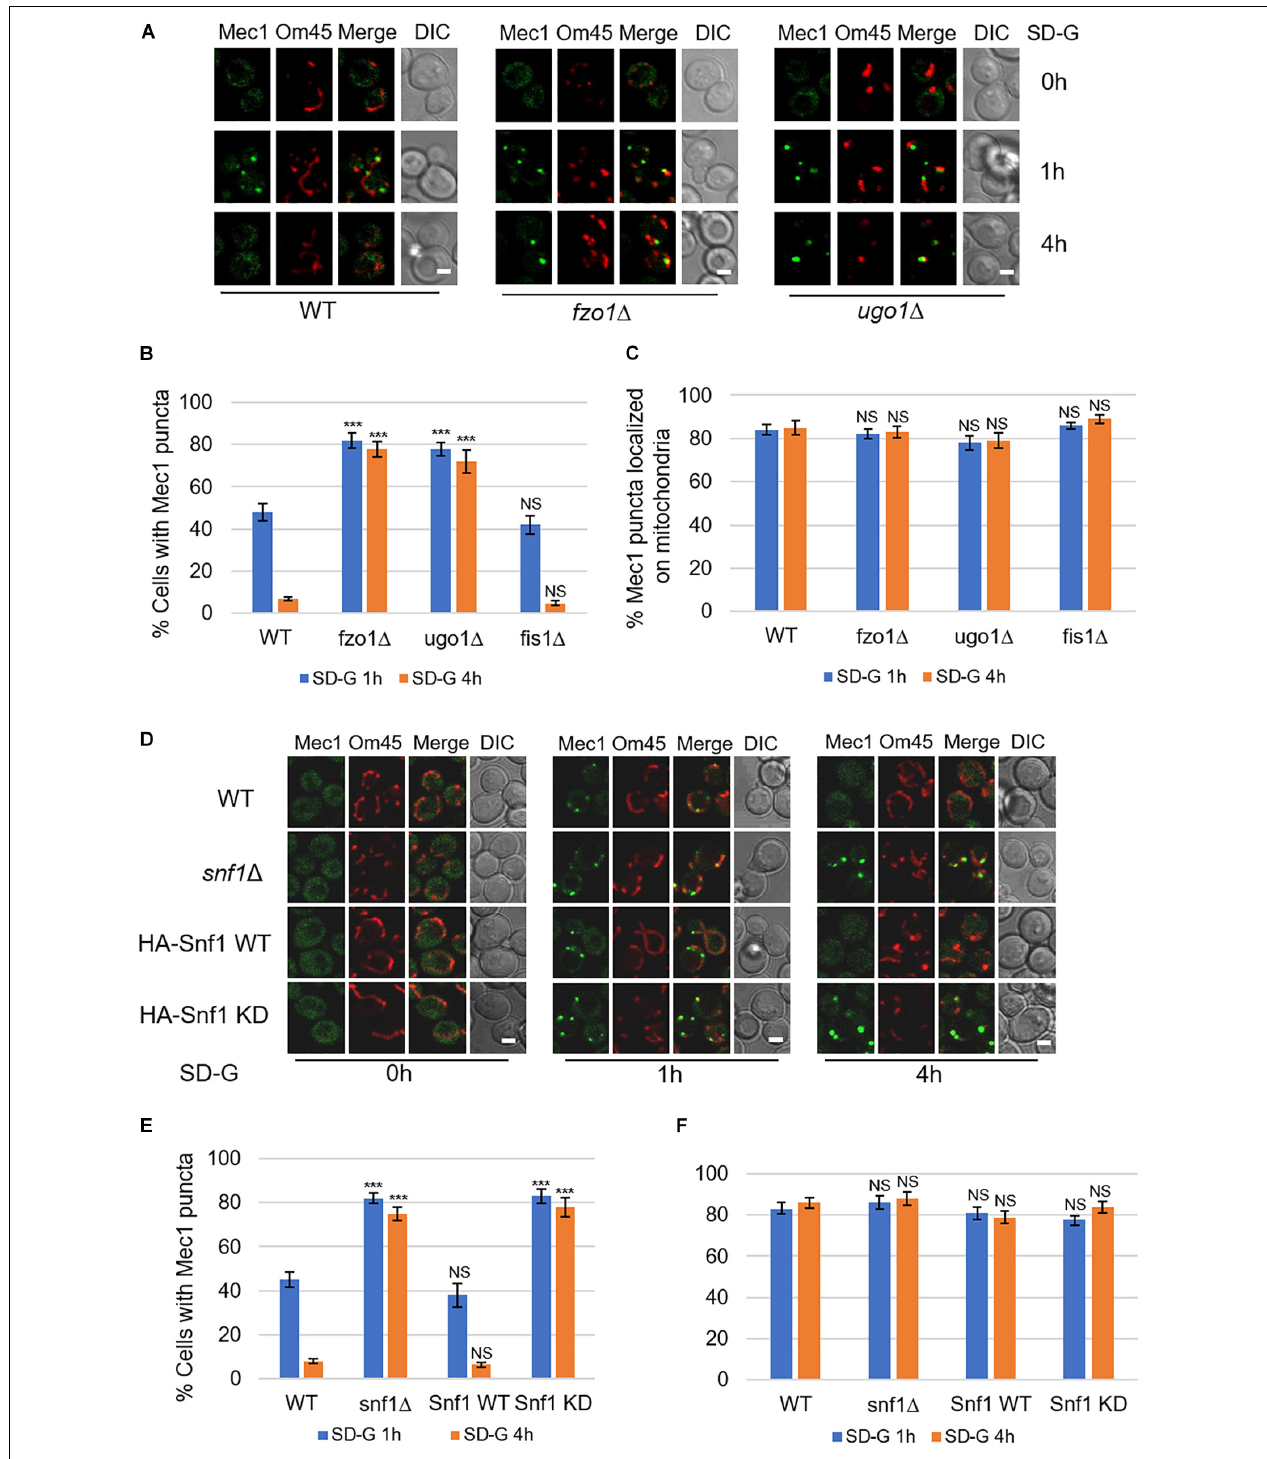
FIGURE 4 | Mitochondrial fusion machinery is required for the dissociation of Mec1 from mitochondria during prolonged starvation. (A,D) Co-expression of GFP-Mec1 and Om45-Cherry were expressed in the indicated yeast strains. Cells were cultured in SD-G medium for 0, 1, and 4 h, and then viewed by laser confocal microscopy. Scale bar, 2 µ m. (B,E) Strains from (A,D) were analyzed for the number of cells with Mec1 puncta. n = 300 cells pooled from three independent experiments. Data are presented as means ± SD. *** p < 0.001; NS, not significant; two-tailed Student’s t -tests were used. (C,F) Quantification of mitochondrial GFP-Mec1 puncta in cells from (A,D) . Mec1 puncta were examined in 300 cells pooled from three independent experiments. Data are presented as means ± SD. NS, not significant; two-tailed Student’s t -tests were used.